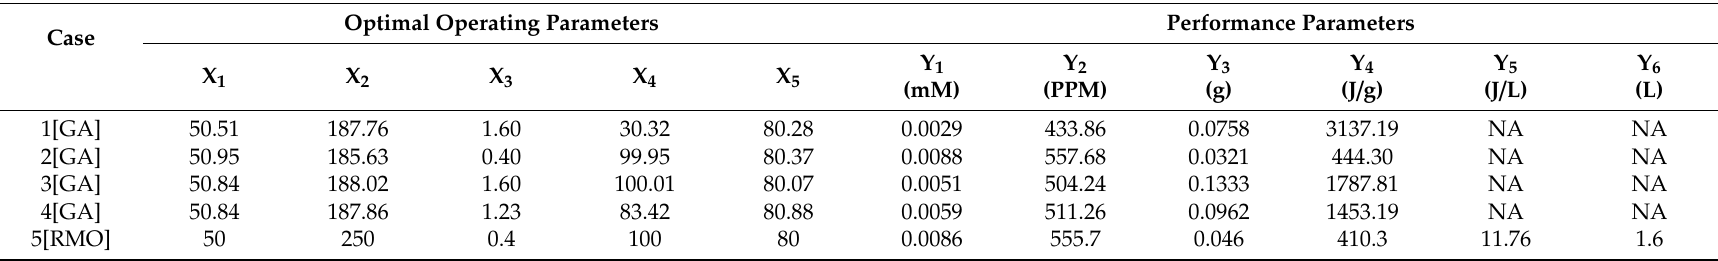
Table6. Multi-constrainedmulti-objectivefunctions(MCMOF)optimization,